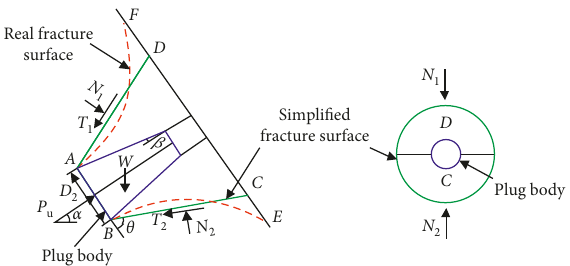
Real fracture surface